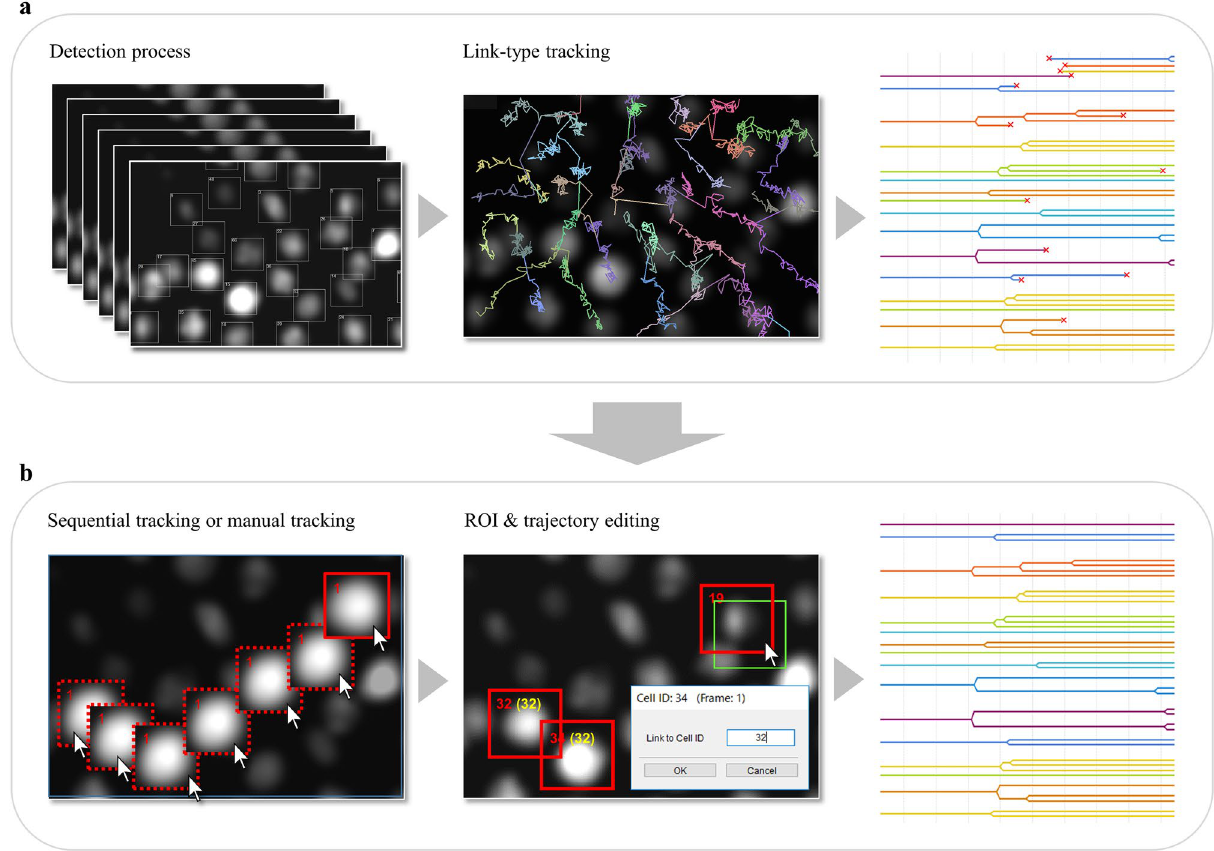
Figure 6. Conceptual diagram of the tracking process. ( a ) Conceptual diagram of the tracking process for an entire frame using link-type tracking. Depending on the detection accuracy and other factors, it may not always be possible to track accurately, but it is easy to detect erroneous tracking by displaying the cell lineage and checking for breaks and branches in the genealogy. ( b ) In addition to link-type tracking, it is possible to seamlessly combine sequential tracking, manual tracking, and ROI/trajectory editing functions. For example, sequential tracking can be used to add or modify trajectories only for mistracked areas, and accurate tracking results can be obtained efficiently through the